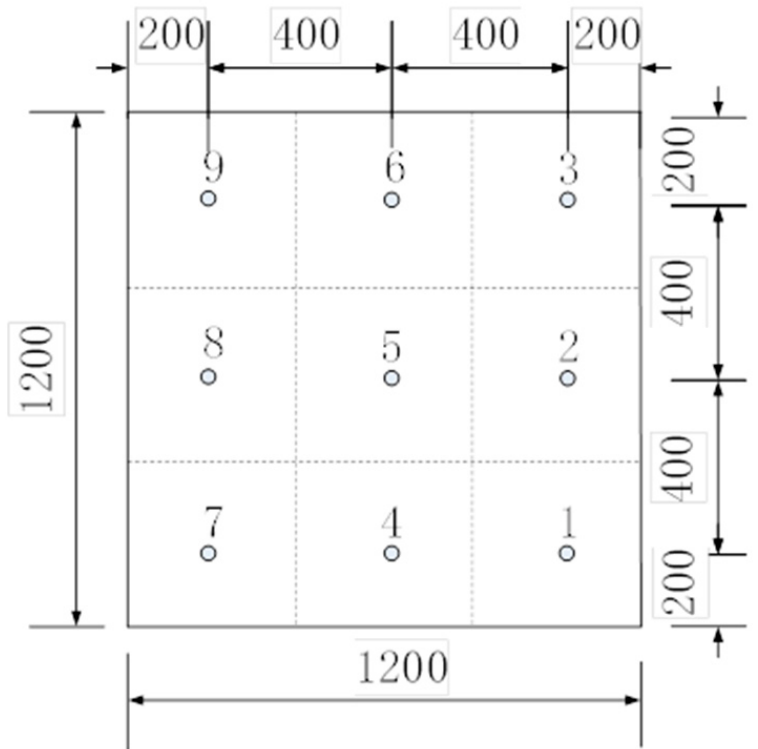
Figure 4. Arrangement of the nine measurement points of the section (unit: mm).